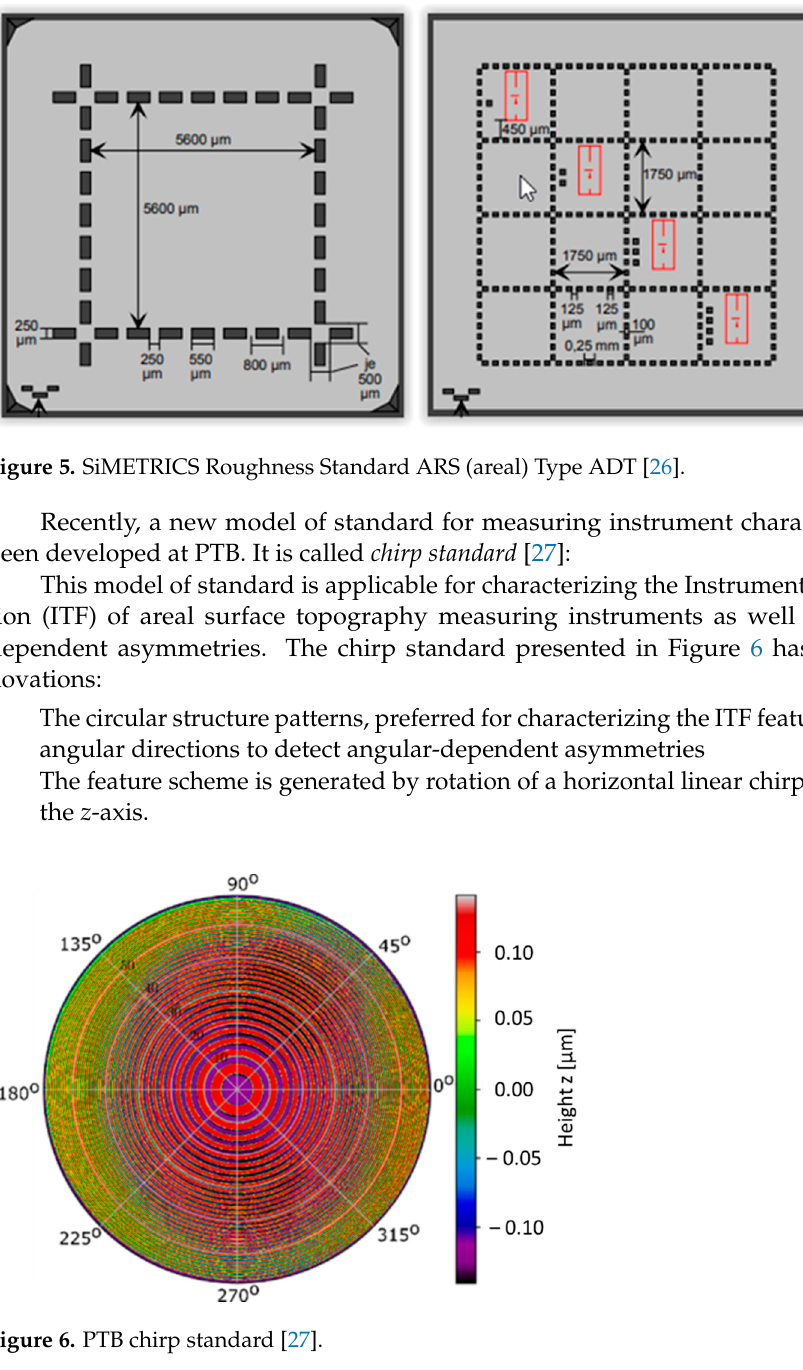
Figure 6. PTB chirp standard [27].